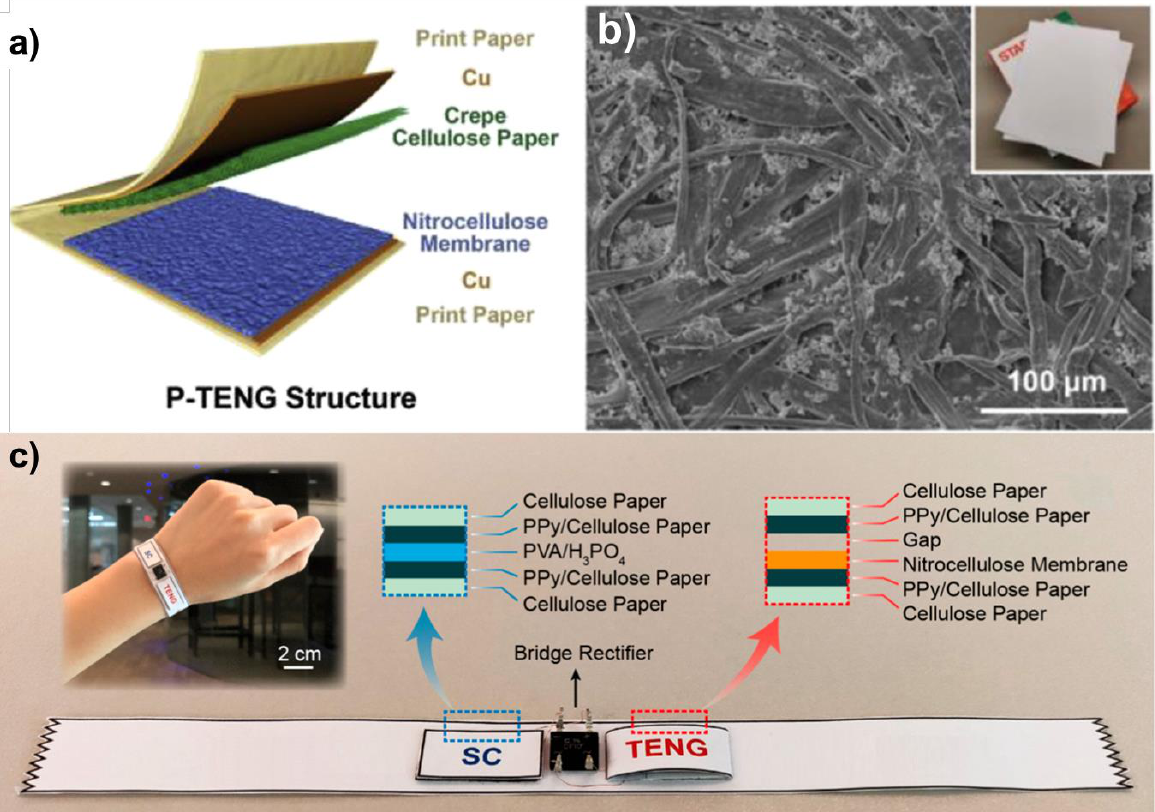
Figure 7. Example of self-powered paper-based devices. ( a ) Crepe cellulose and nitrocellulose membrane papers are used as environmentally friendly materials for triboelectric power generation, ( b ) SEM image of the cellulose structure is also shown, figure adapted from Chen et al. [119]. ( c ) Here, paper is used both for the power generation, with a paper-based TENG device, but also for storage using a paper-based supercapacitor, image adapted from Shi et al. [121].